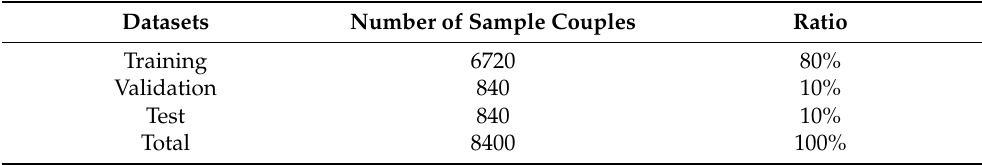
Table 1. Details of training, validation, and test datasets.